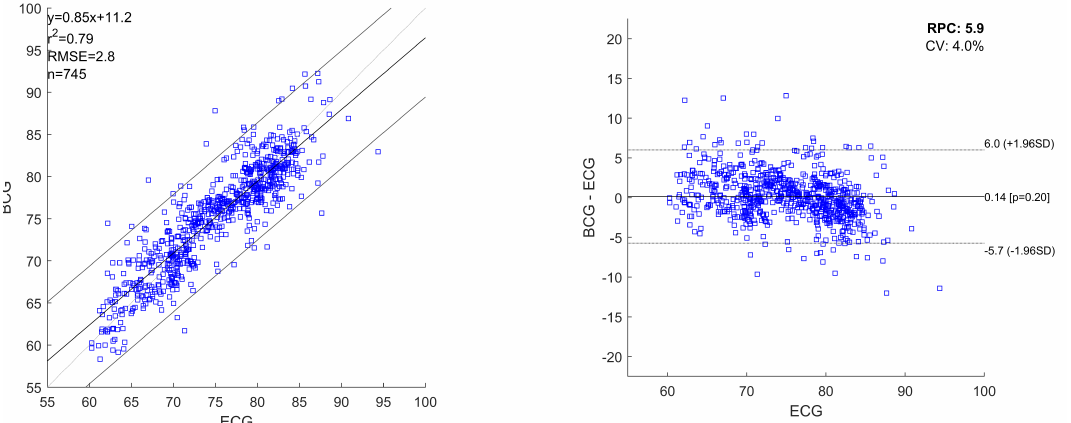
Figure A2. Linear regression plot and Bland-Altman plot of the the analysed heartbeats for ECG and BCG considering the temporal lengths of 5 s for the epochs. The heartbeats are pooled over all the recordings. In the plots are reported: linear regression equation, squared Pearson r-value ( r 2 ), root mean squared error (RMSE), number of heartbeats analysed (n), reproducibility coefficient (RPC) and coefficient of variation expressed as a percentage (CV). The lines of mean of difference between ECG and BCG, and 95% limits of agreement are